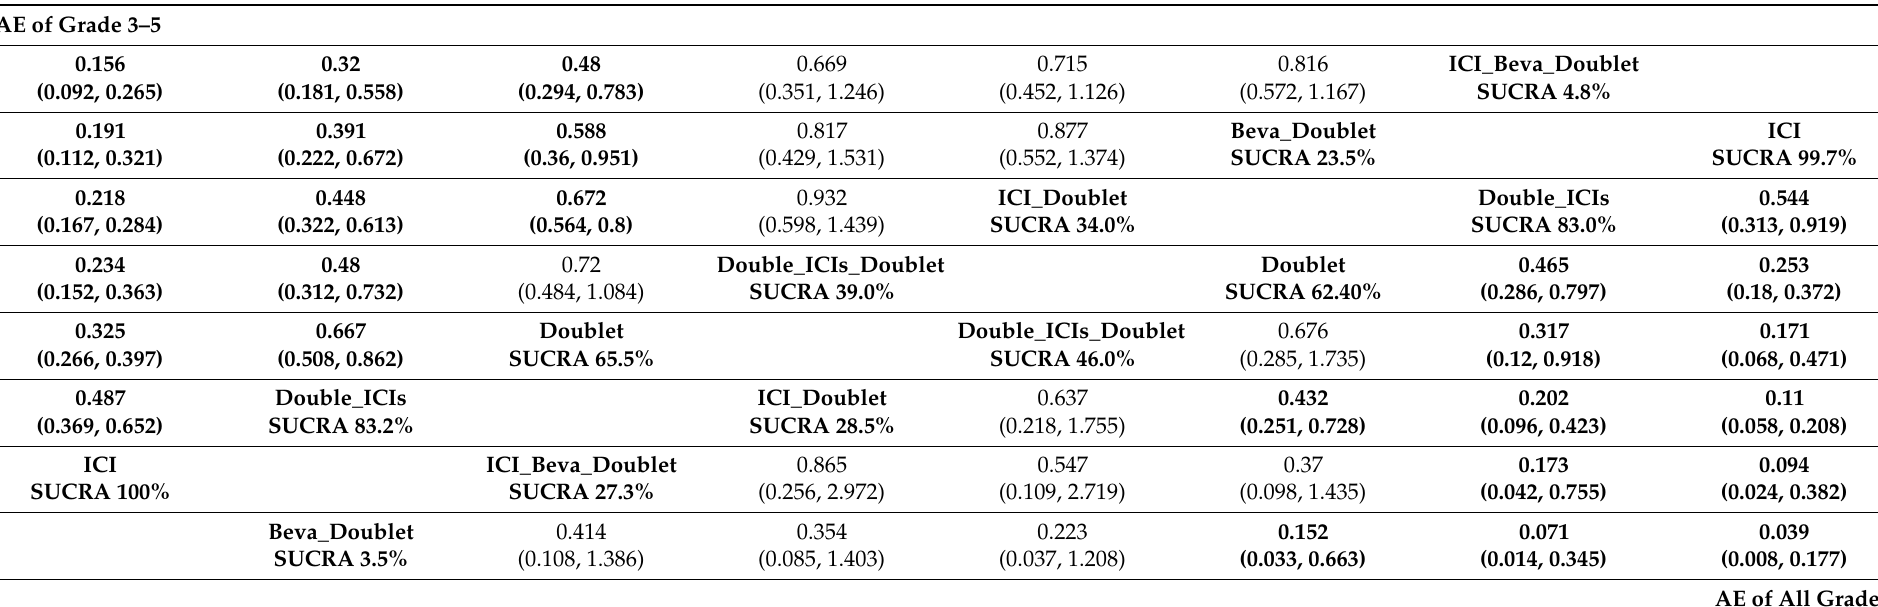
Table 3. The league table presenting the ORs for all pairs of the network nodes and ranking for the probability of each network node to be the best for AE of Grade 3–5 and AE of all grades based on the SUCRA